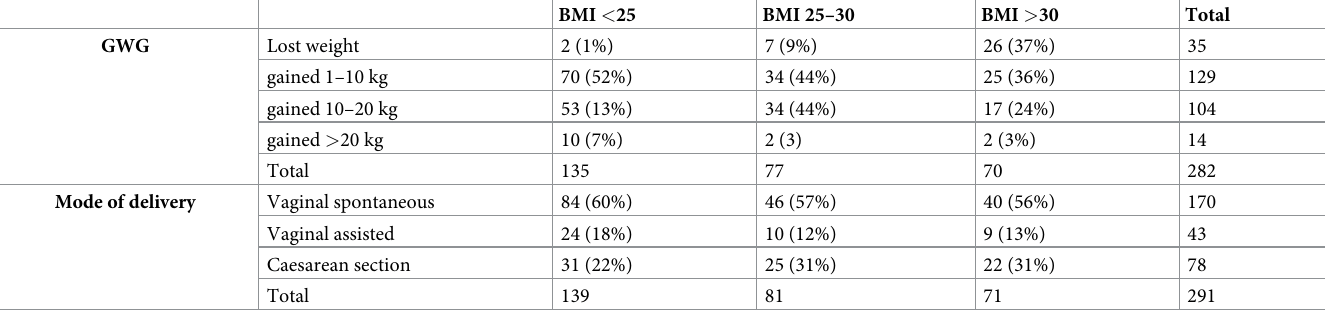
Table 1. Levels of gestational weight gain and birth outcomes of mothers based on different BMI (kg m -2 ) categories.